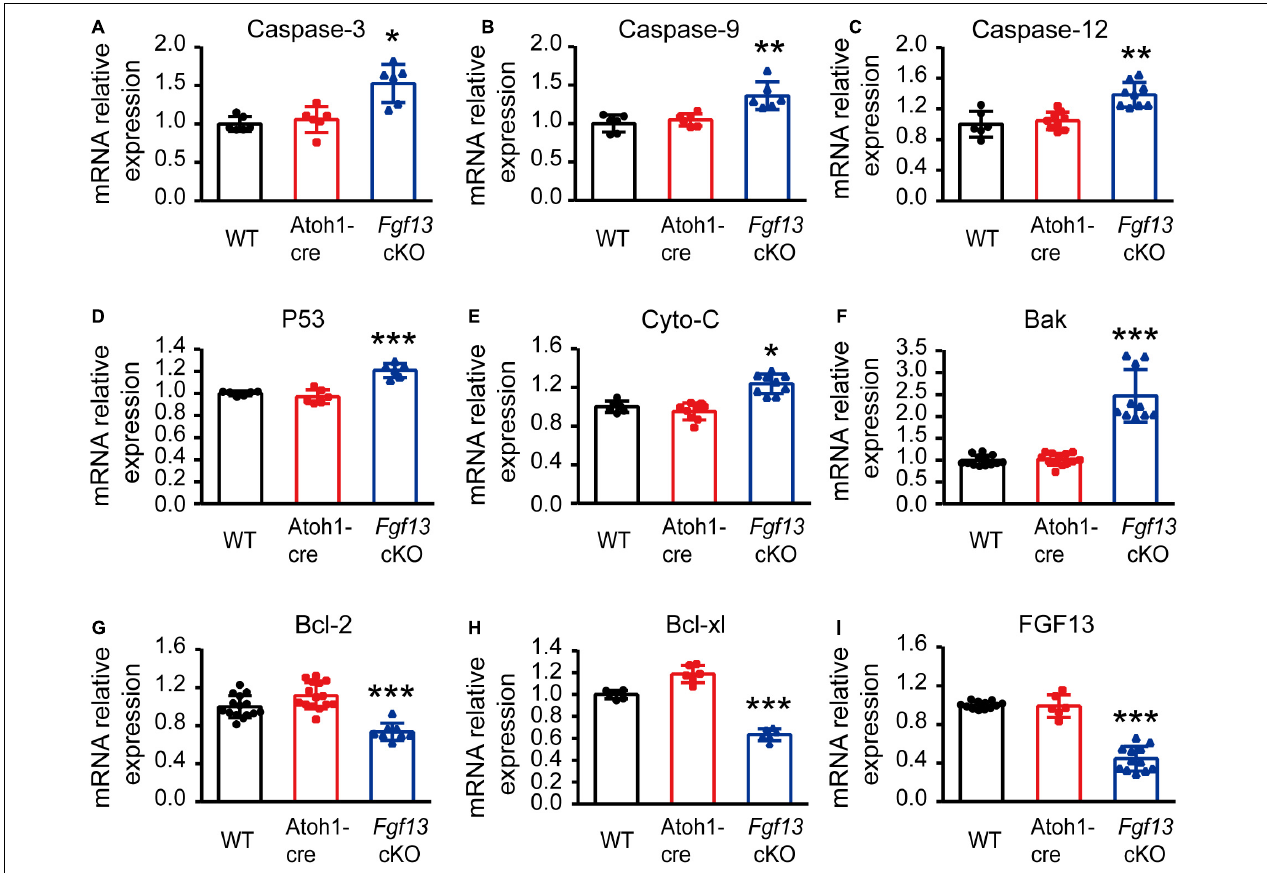
FIGURE 9 | Fgf13 deficiency changes apoptosis related gene expression through qRT-PCR. qRT-PCR data show significantly higher mRNA levels of caspase-3, caspase-9, caspase-12, P53, cytochrome C and Bak (A–F), and lower levels of Bcl-2 and Bcl-xl (G,H) accompanied by ∼ 53% reduction of FGF13 (I) in Fgf13 cKO mice compared to the controls. Gene expression was calculated using the 2 − (cid:49)(cid:49) Ct method. Ct values were corrected for GAPDH and normalized to the WT group. * P < 0.05, ** P < 0.01, and *** P < 0.001 compared with controls as detected by One-way ANOVA test.